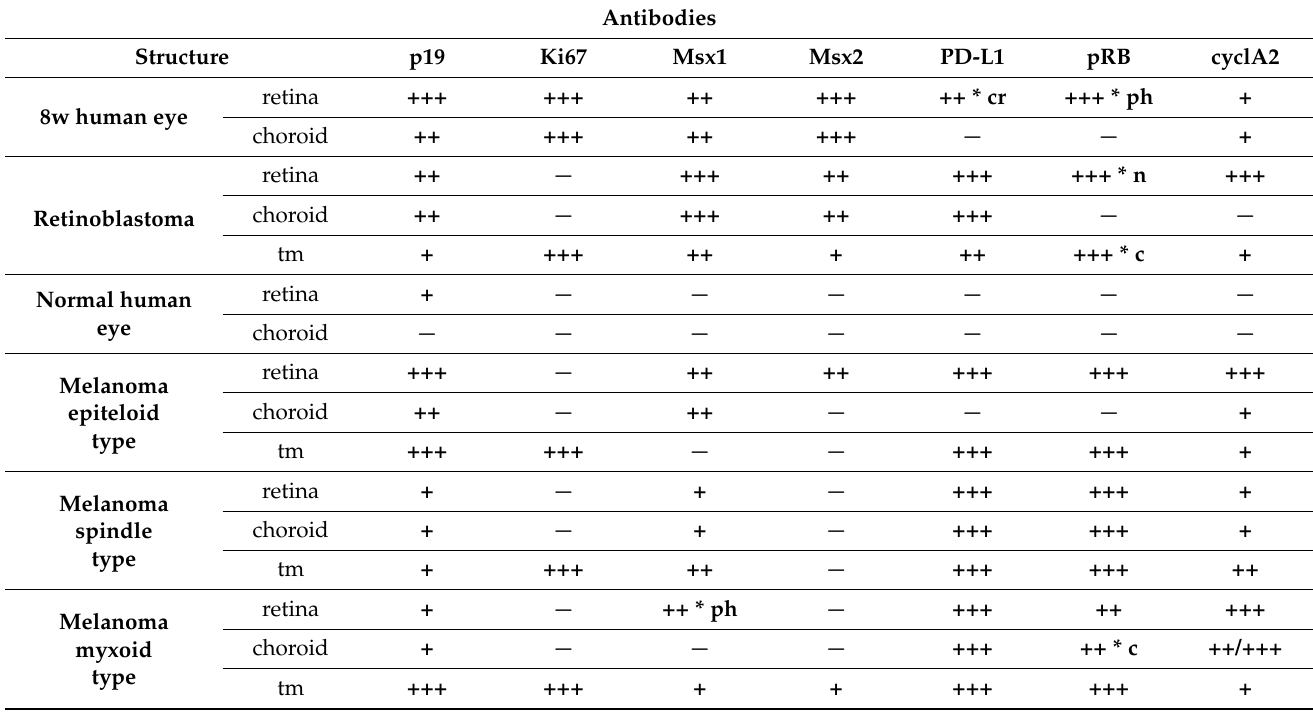
Table 1. Immunoreactivity to specific antibodies compared: 8w human eye development, retinoblas- toma, normal human eye, choroidal melanomas in three subtypes, epiteloid, spindle, and